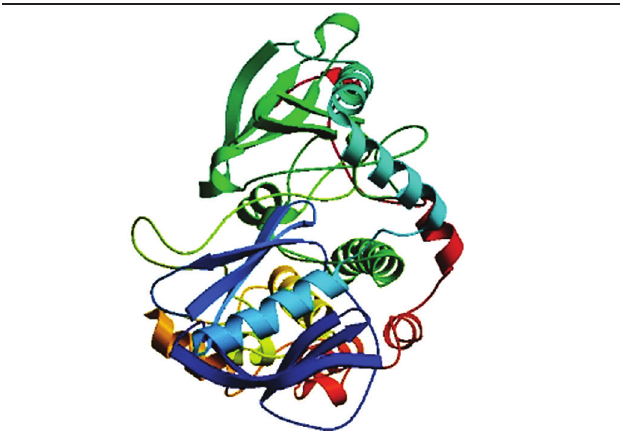
figurE 10 − Phosphoinositide 3-kinase (PI3K)/AKT